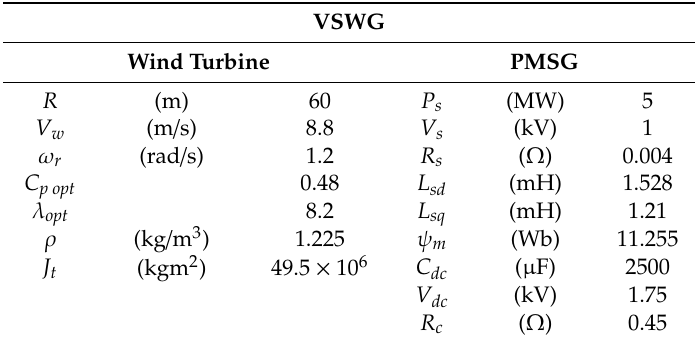
Figure 7. Control model of the VSWG: ( a ) overall; ( b ) stator side controller; ( c ) grid side controller; ( d ) protection circuit of DC-link. Table 2. VSWG